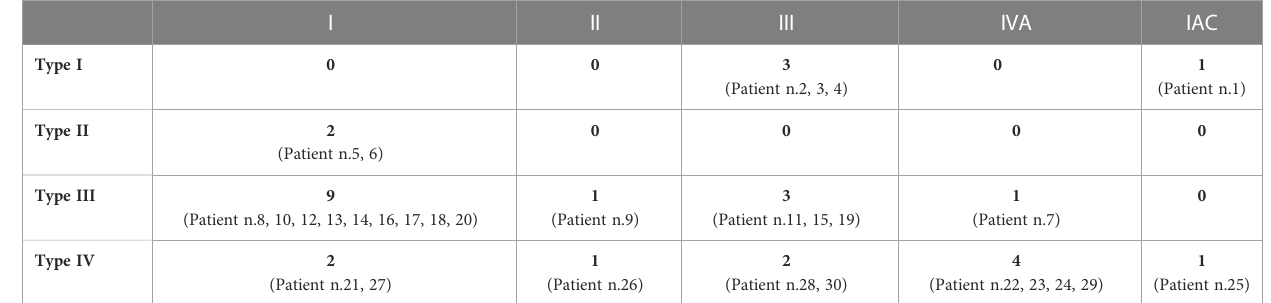
TABLE 3 The MTC risk strati fi cation in synchronous tumors of 4